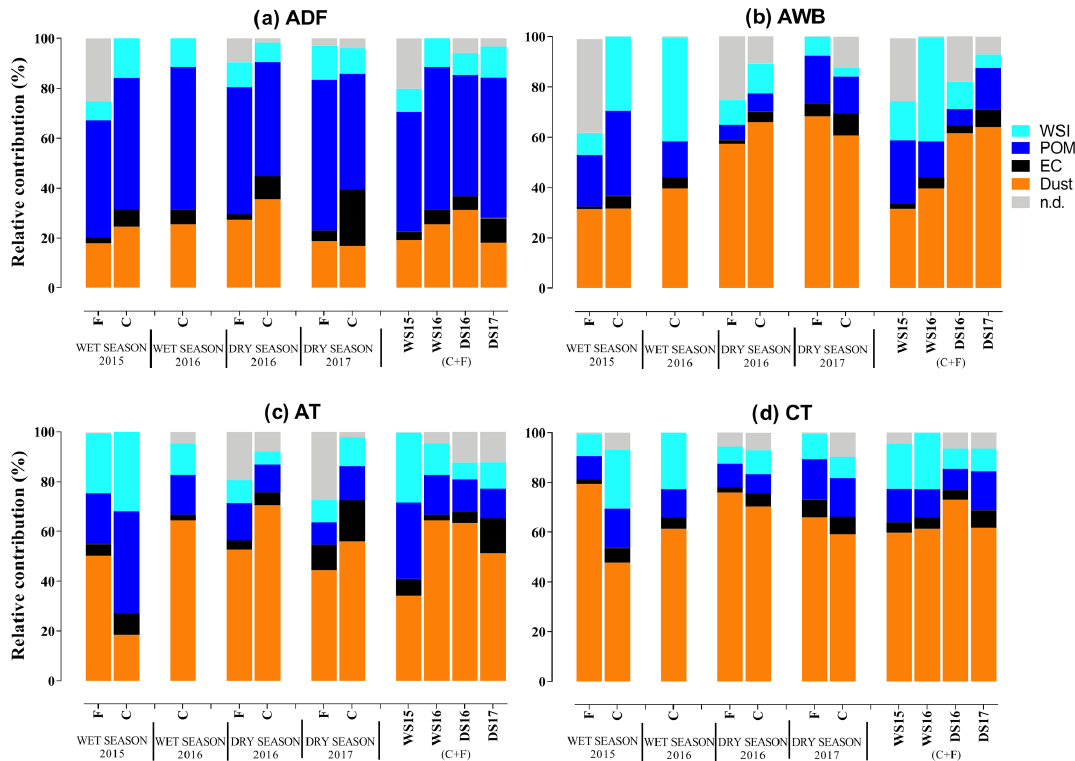
Figure 13. Size-speciated aerosol chemical composition for each site, for each campaign, and each aerosol